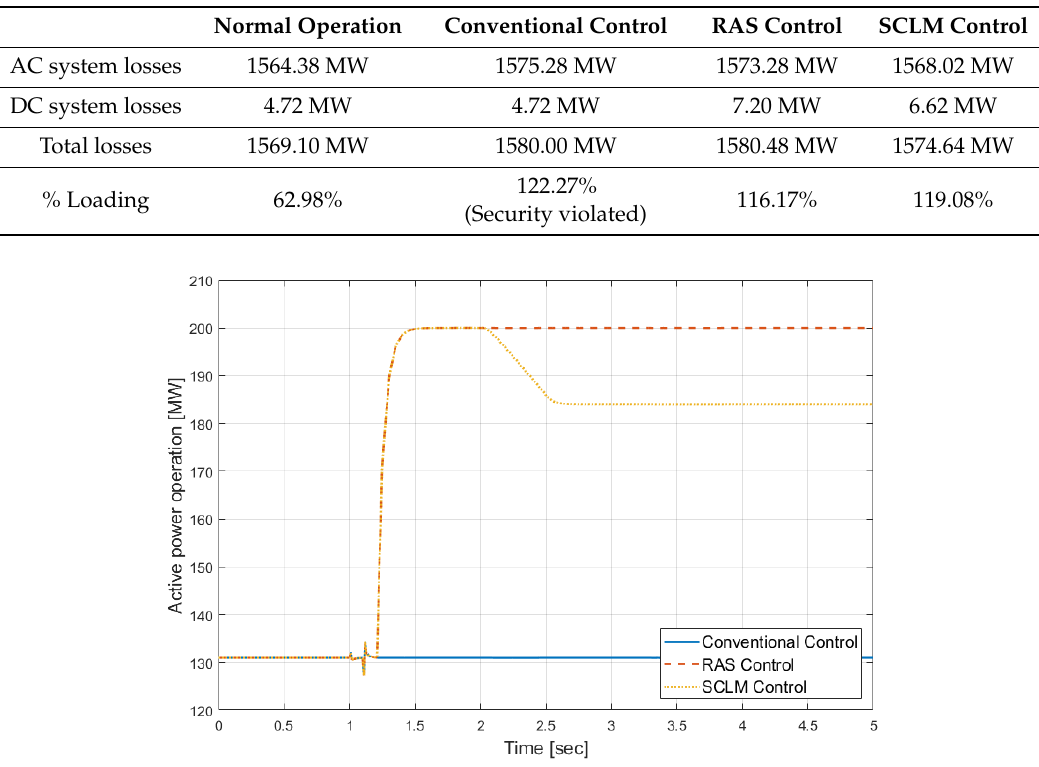
Figure 12. Active power operation change in the line overload case.